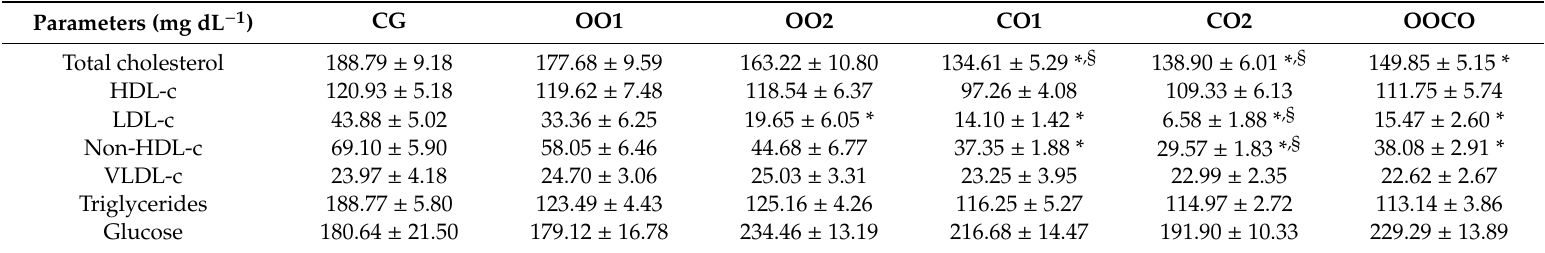
Table 3. Biochemical parameters of animals after 90 days of Caryocar brasiliense oil supplementation.